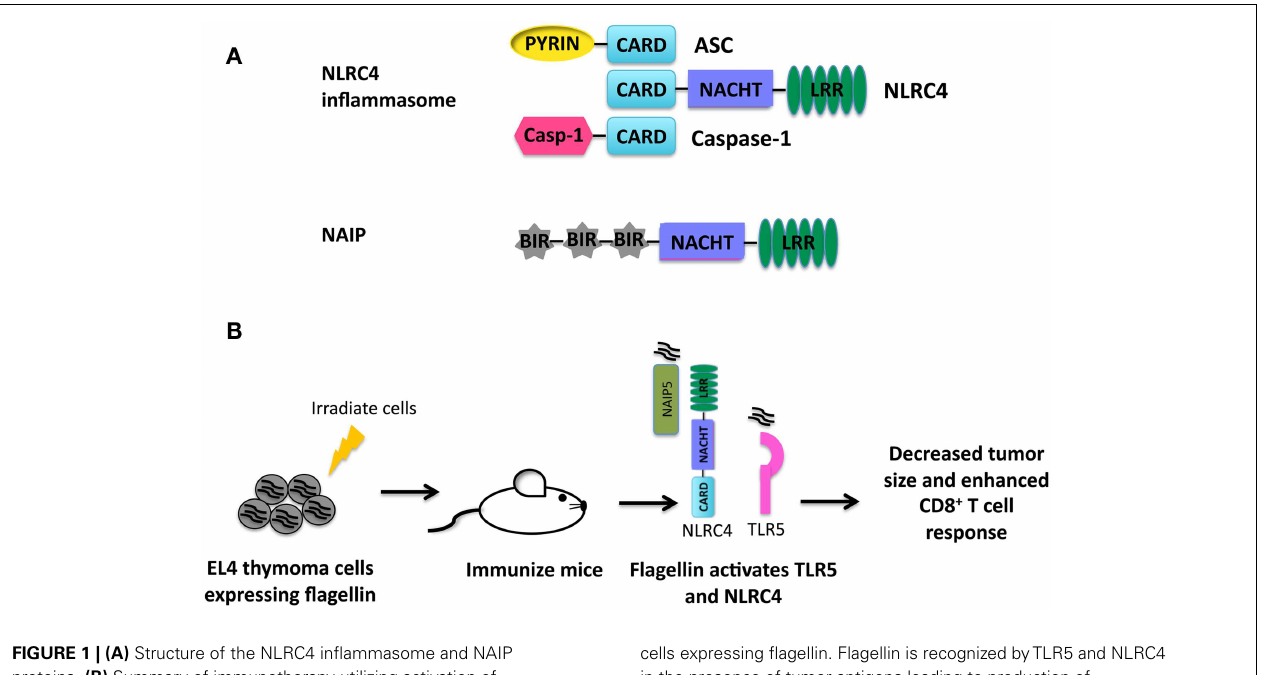
FIGURE 1 | (A) Structure of the NLRC4 inflammasome and NAIP proteins. (B) Summary of immunotherapy utilizing activation of NLRC4 (43). EL4 thymoma cells were transduced to express flagellin from S. typhimurium . Mice were then immunized with irradiated EL4